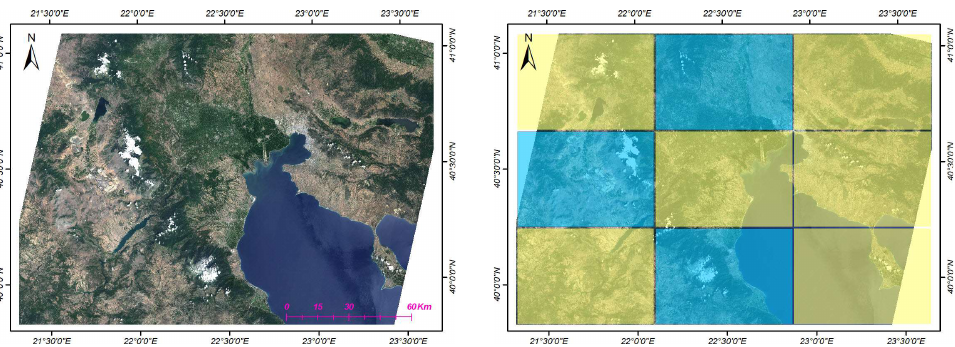
Figure 1. The study area is located in northern Greece, as can be seen in a natural color Landsat-8 (L8) composite from year 2016 ( left ) and covers an area of about 26,000 km 2 . The study area was partitioned in order to form independent training and testing datasets: training blocks are pictured in yellow, while testing ones with a cyan ( right